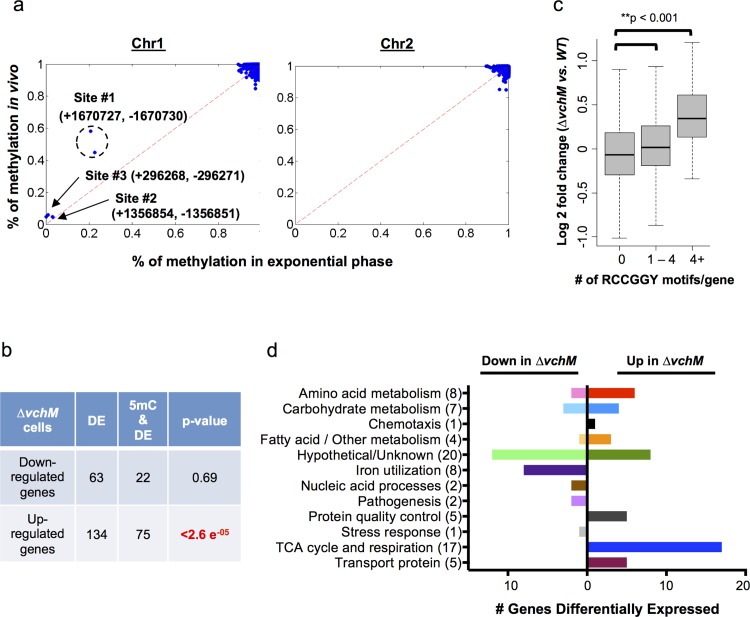

V. cholerae cytosine methylation and its associations with gene expression.(A) The extent of VchM target site (RCCGGY) methylation on chromosomes I and II, as determined by bisulfite sequencing of DNA from exponential phase cultures, is plotted against the extent of methylation for these sites during infection. Three sites (#1-#3) were found to be persistently non-methylated; numbers designate the genomic position of each site on the forward (+) or reverse (-) strand. (B) Genes that were significantly (p-val <0.01) differentially expressed by wt and ∆vchM cells were correlated with the presence of intragenic RCCGGY motifs. Significance was assessed using a Fisher’s exact test by the comparing the fraction of differentially expressed genes containing RCCGGY motifs (e.g., 22 out of 63) to the fraction of all genes in V. cholerae containing RCCGGY motifs (1460 out of 3842 genes). Significant enrichment of motifs was found within only the genes that were upregulated in ∆vchM cells. DE = number of differentially expressed genes; 5mC = number of genes containing methylated RCCGGY motifs. (C) Differences in transcript abundance between exponential phase cultures of ∆vchM and WT cells are plotted relative to the number of RCCGGY motifs present within the coding region for each gene. The boxes represent the fold change of genes in the 25%-75% quartile with the median fold change shown as a line. The whiskers represent 1.5 fold of the interquartile range (the third quartile minus the first quartile) away from the box. (D) The numbers of genes that are differentially expressed (p-value <0.05) by ∆vchM strains of C6706 and O395 V. cholerae compared to their parental strains are shown for a variety of biological categories.